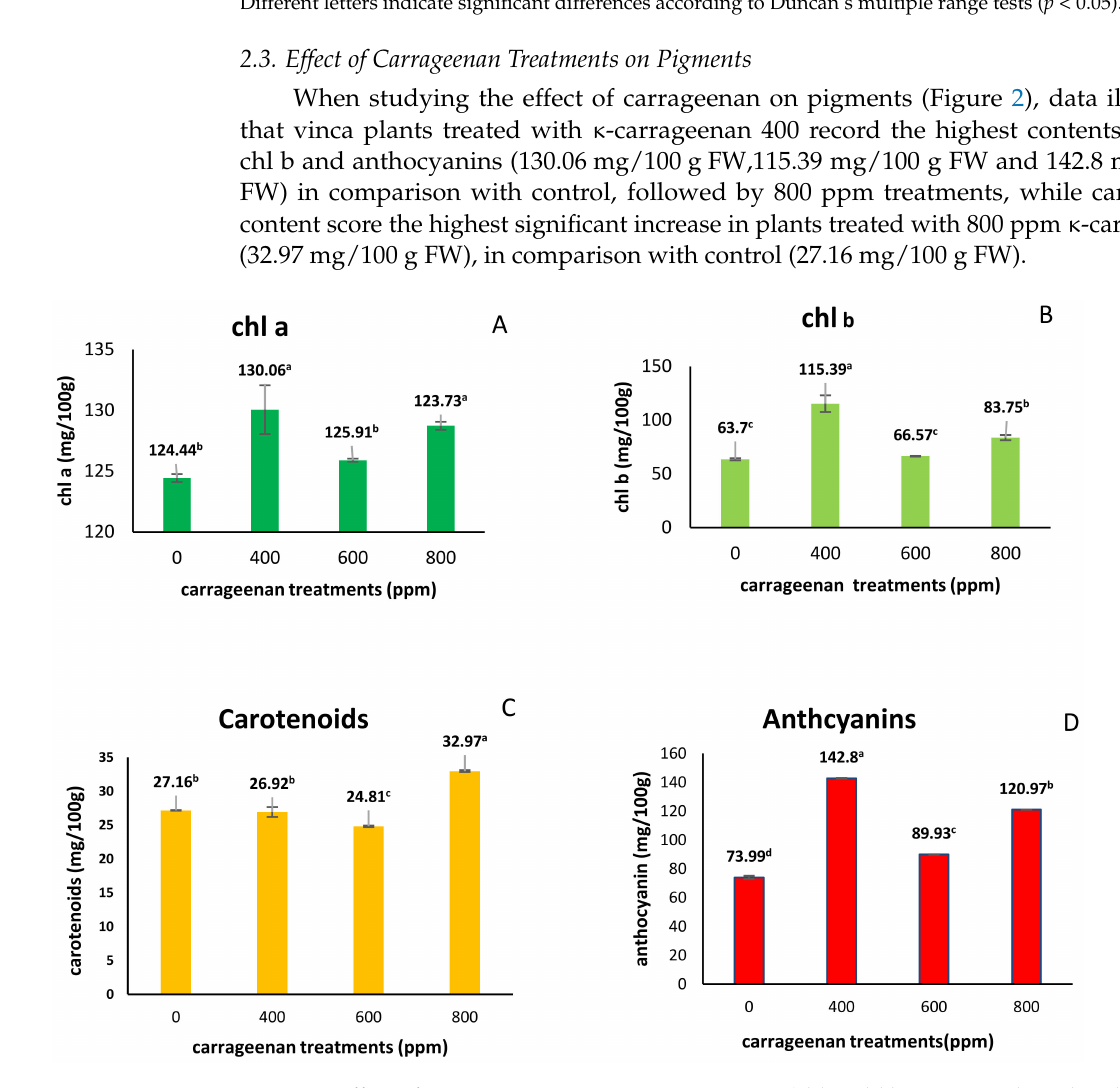
Figure 2. Effect of Carrageenan spraying on pigments (chl a, chl b, carotenoids and